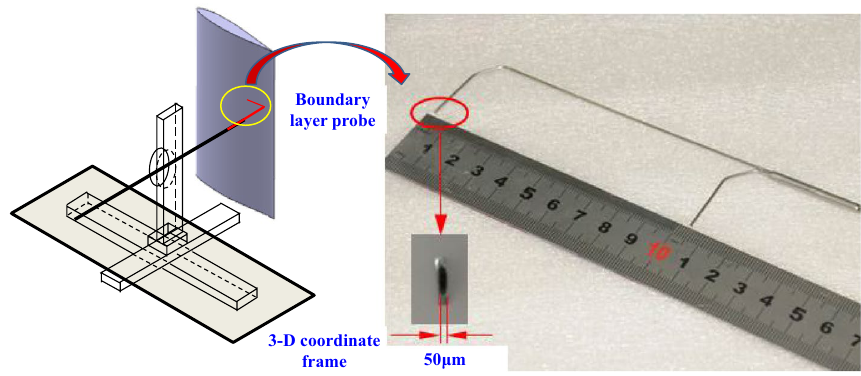
Figure 6. Schematic diagram of boundary layer